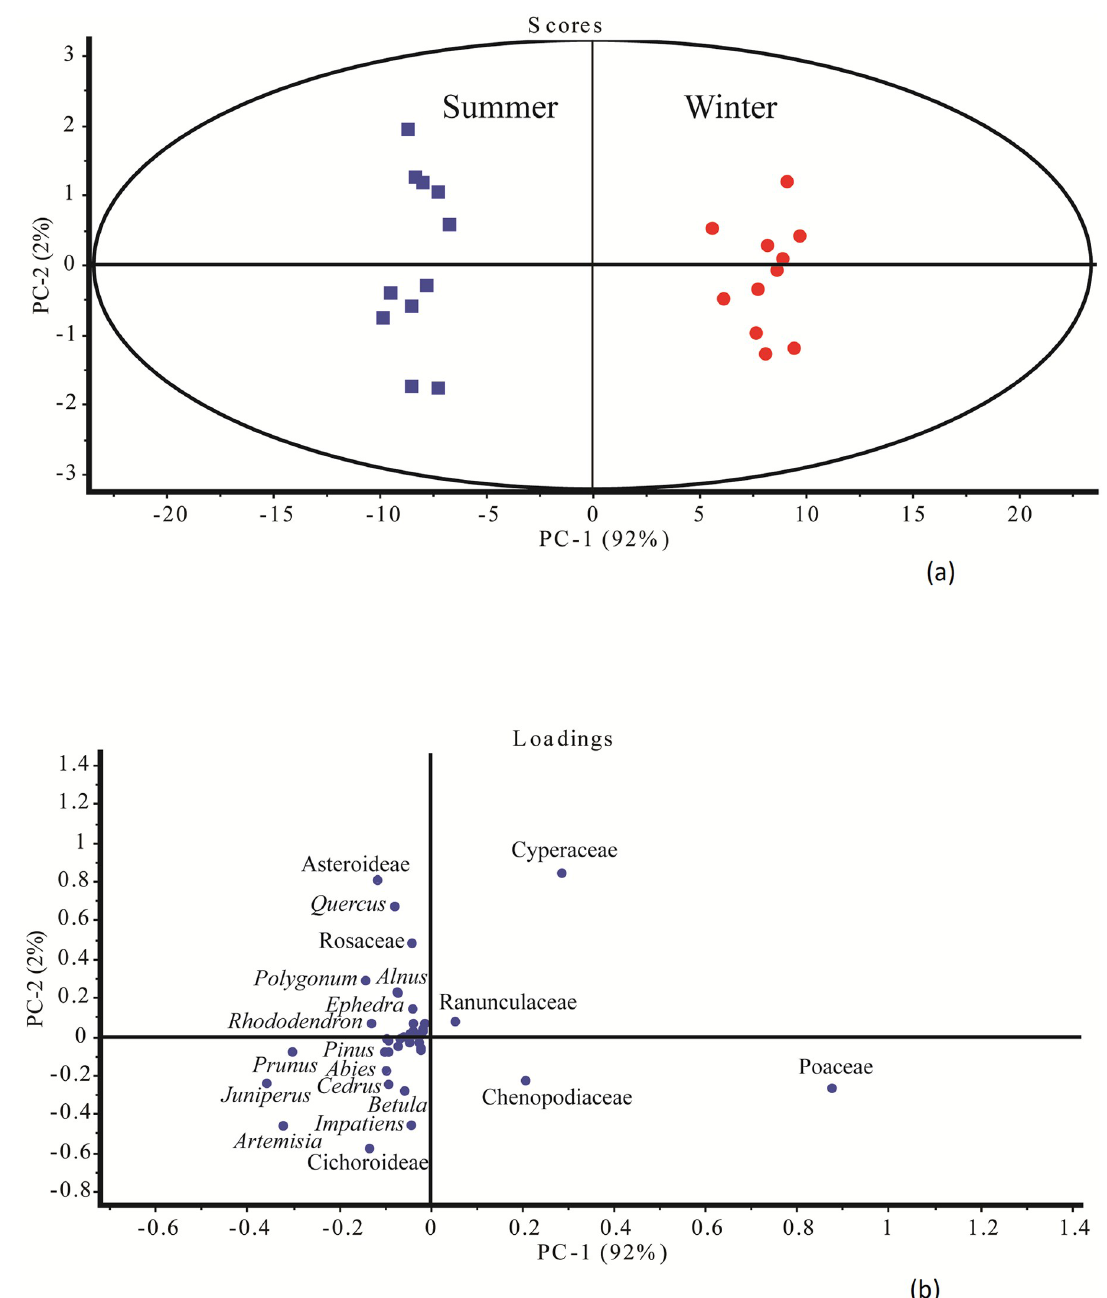
Fig 6. ThePCA analysis of the Yak dung between summer (a) and winter (b)